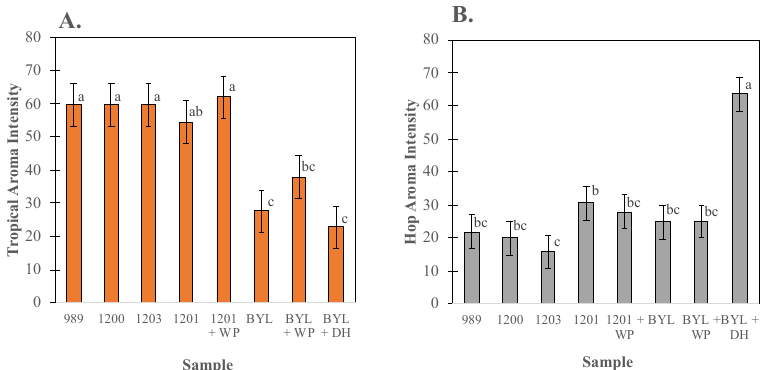
Figure 3. Tropical aroma intensity ( A ) and overall hop aroma intensity ( B ) from attribute scaling data (0–100 scale). Error bars represent standard error and data labels that share a letter (a, b, c) are not significantly different (Fishers LSD, P value <0.05).